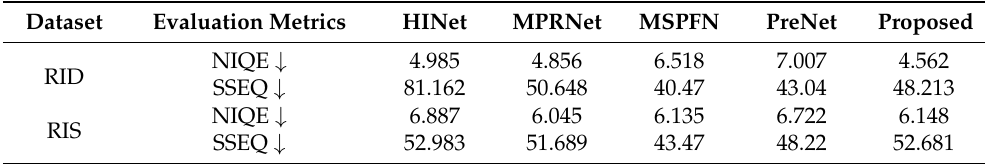
Table 4. Comparison results of average NIQE/SSEQ on real-world dataset (RID and RIS). The smaller scores indicate better perceptual quality. Dataset